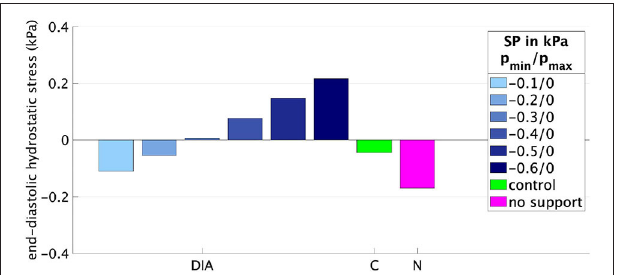
FIGURE 7 | End-diastolic hydrostatic stress for different support pressures (SPs) applied to the rat LV with fib = 0.5. DIA, diastolic support; C, control rat LV; N, rat LV with fib = 0.5 without any